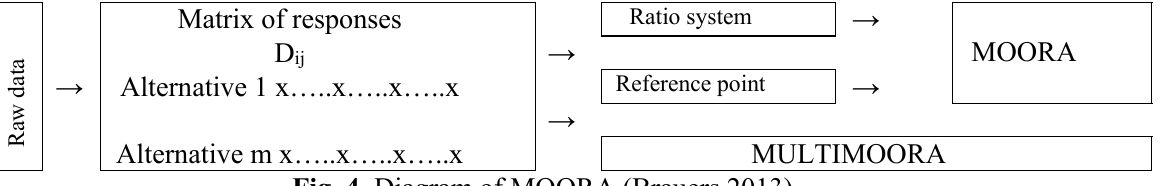
Fig. 4. Diagram of MOORA (Brauers